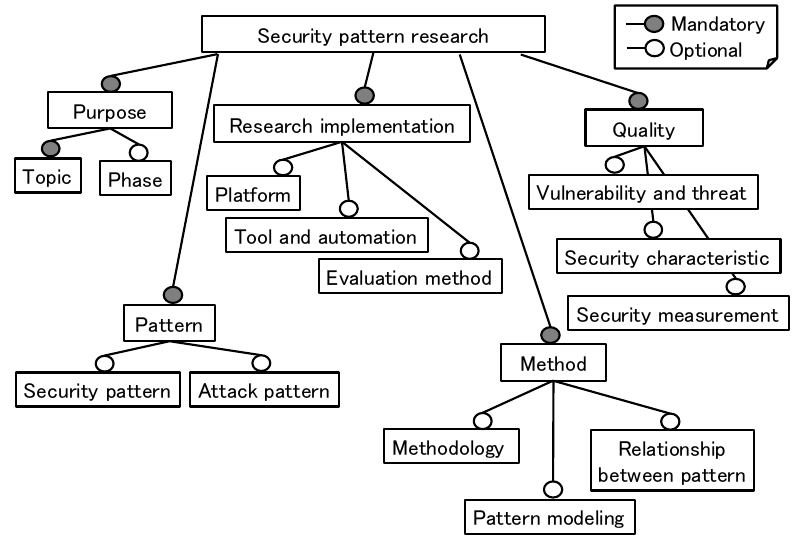
Figure 2. Feature diagram of the taxonomy (adopted from [247] with reduction of several features for